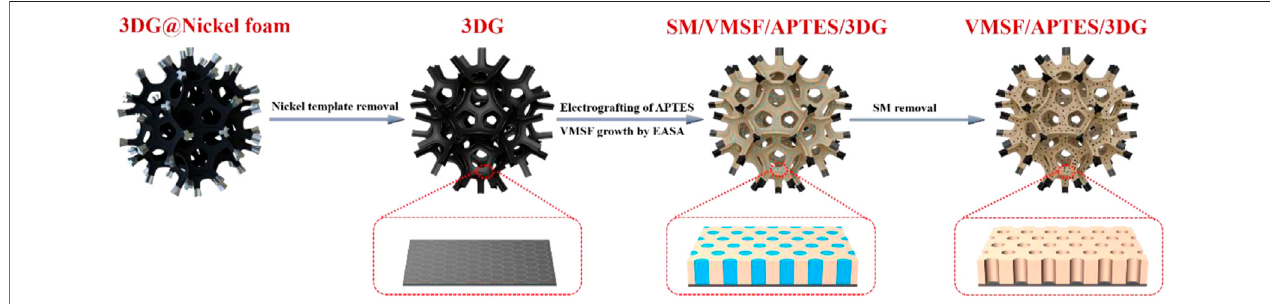
FIGURE1| Schematicillustrationforthepreparationofverticallyorderedmesoporoussilica-nanochannel fi lms(VMSFs)/(3-aminopropyl)trimethoxysilane(APTES)/ three-dimensional grapheme (3DG).